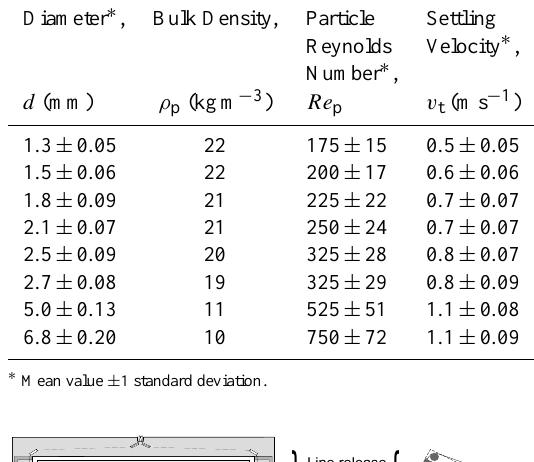
Table 1. Properties of EPS beads used in our experiments. Diameter ∗ ,